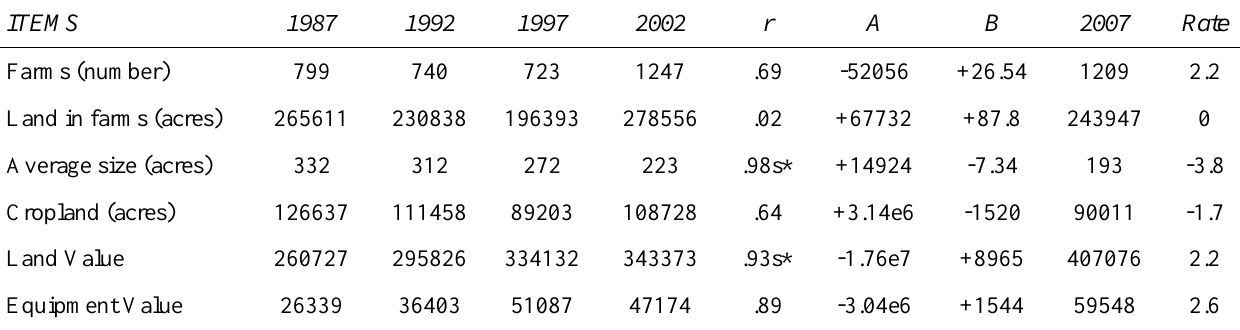
Table 2b: Hind County Regression Analysis